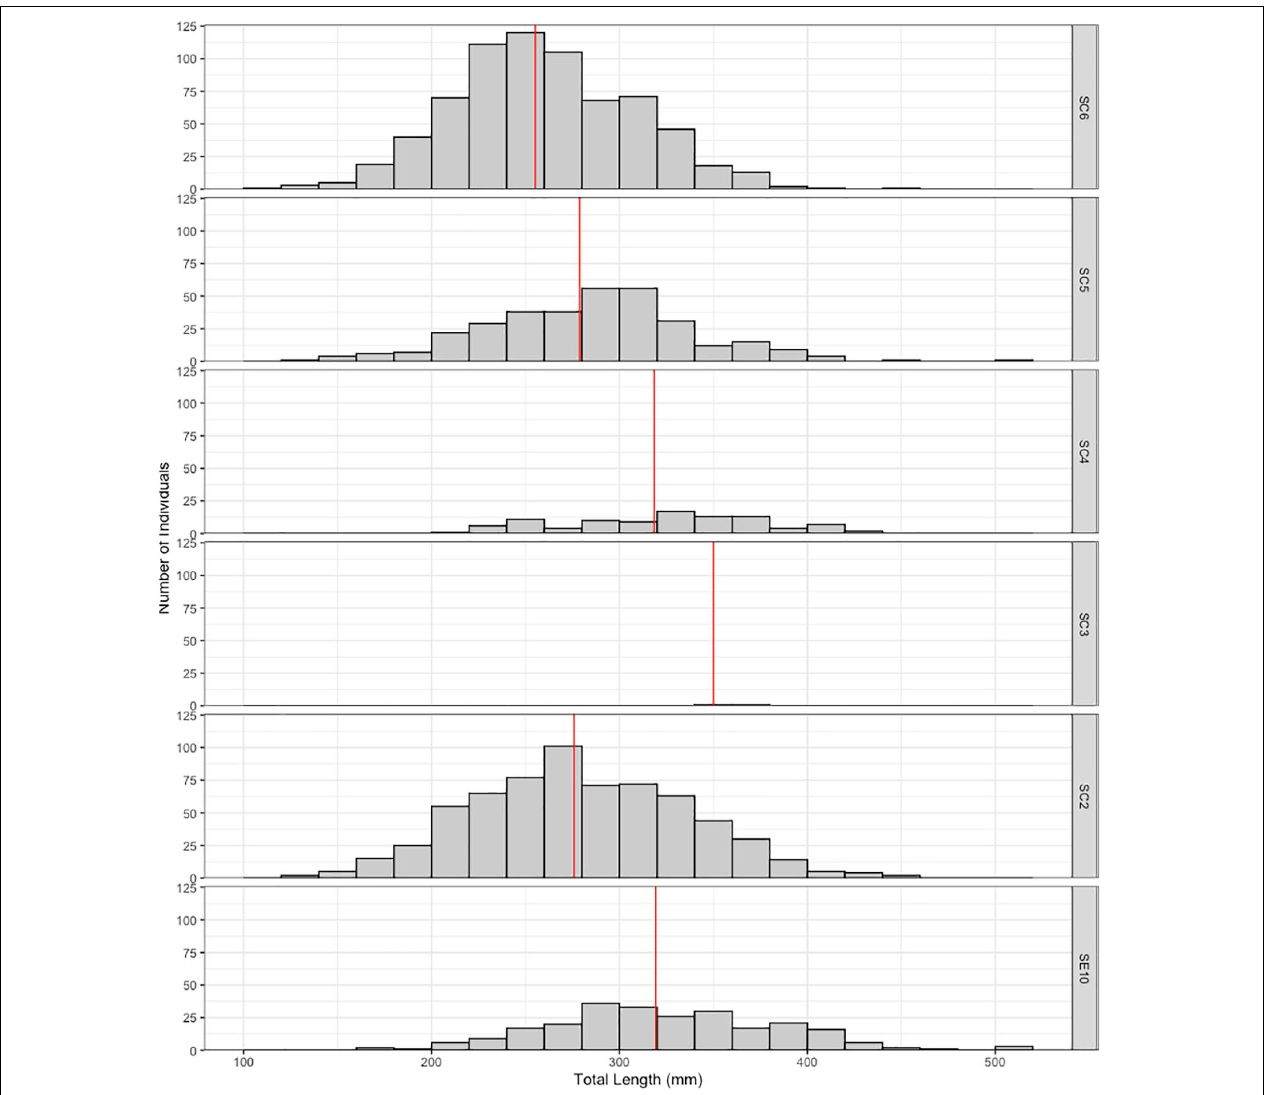
FIGURE 5 | Size-class distribution of Holothuria mammata by sampling site, arranged according to distance to estuary (bottom to top). Vertical lines represent the site